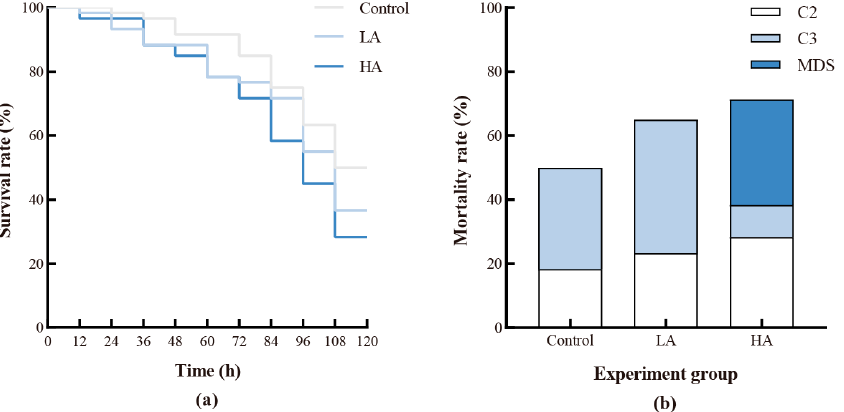
Figure 1. Survival rate ( a ) and mortality composition ( b ) of P. trituberculatus in different groups. The juvenile crabs in all three groups started moulting after 72 h, and all of the sur- viving crabs completed moulting before 120 h (Figure 2). Ammonia exposure significantly affected the moulting rate at different times (72 h, p = 0.020; 96 h, p = 0.001; and 120 h, p = 0.000). At 72 h, the moulting rate in the LA group was significantly higher than that in the other groups, which were 2.60 and 3.25 times that of the control and HA groups, respectively. At 96 h, the highest moulting rate was also observed in the LA group. The moulting rate in the HA group was significantly lower than the other two groups at 96 h and 120 h.